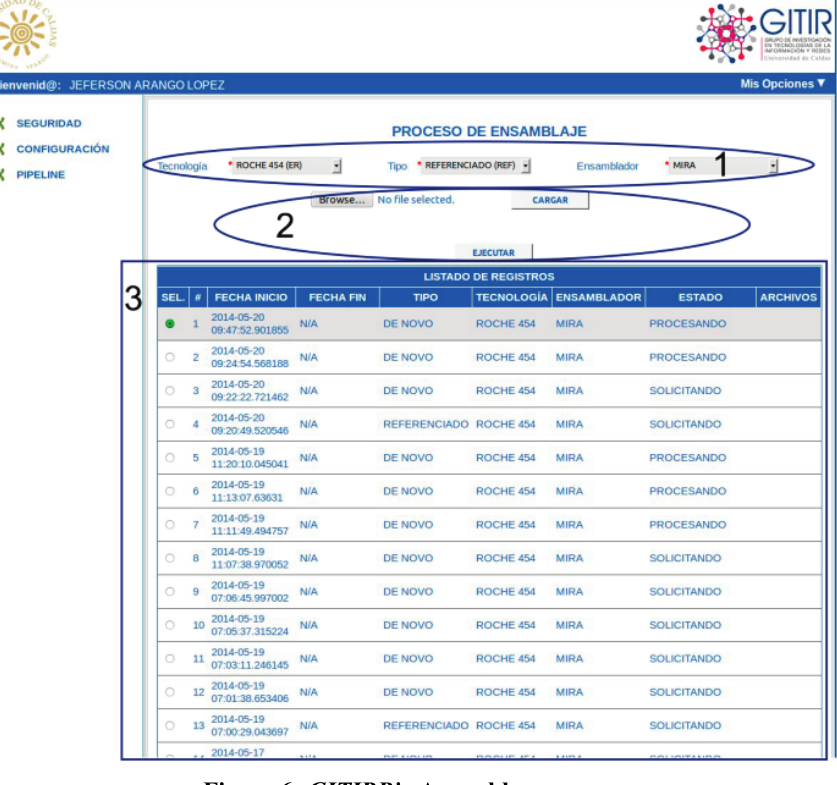
Figure 6: GITIRBio Assembly process.